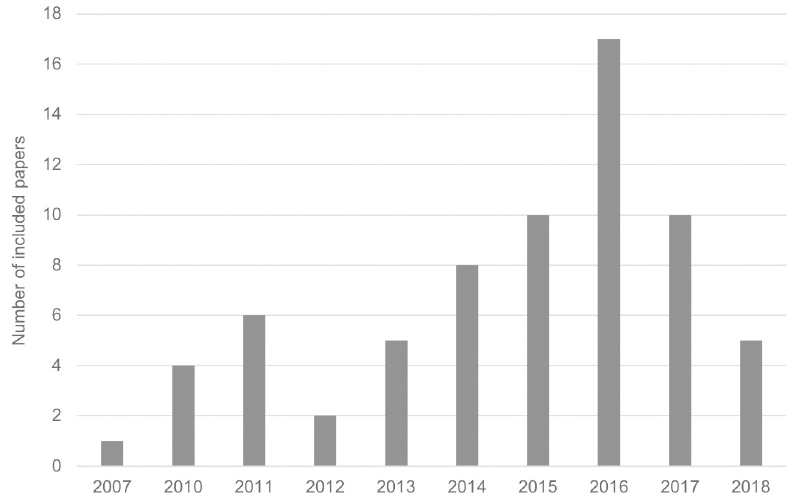
Fig 2. The number of studies that used food sales data by year of